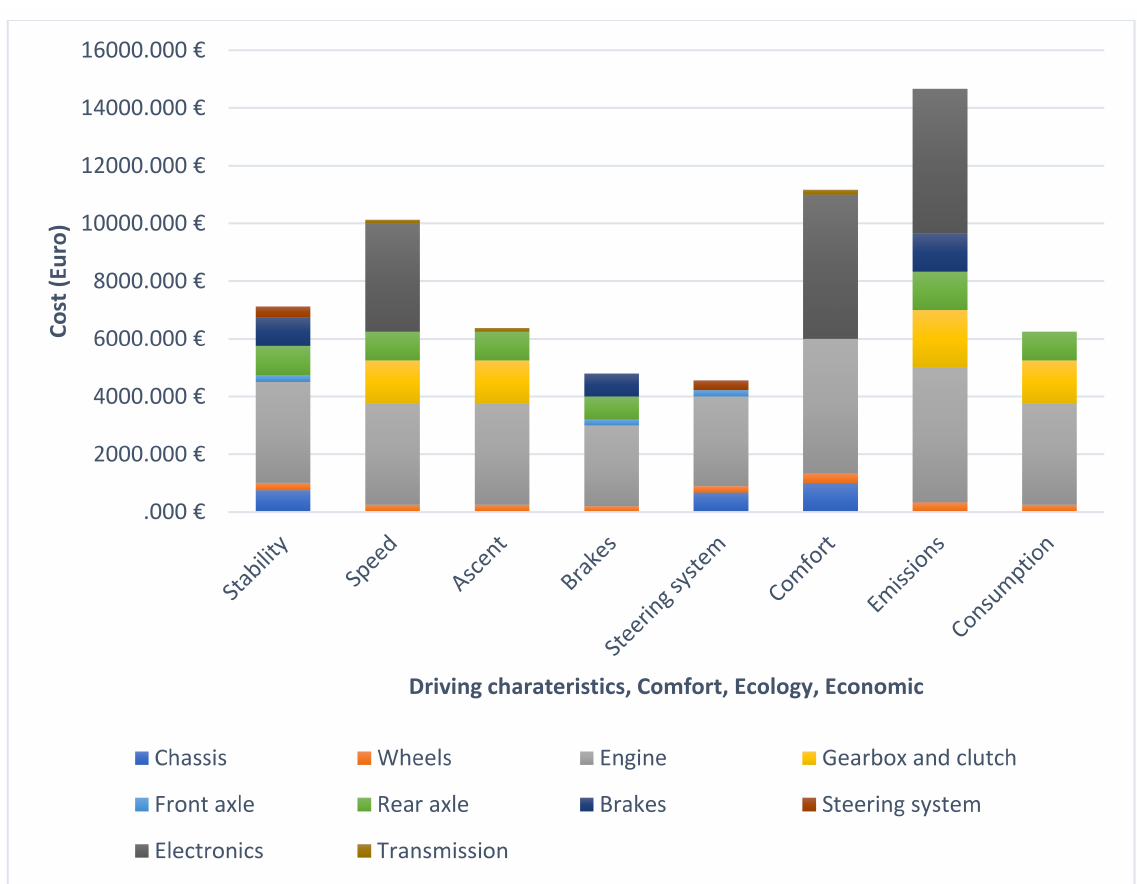
Figure 2. Cost structure of the main components relating to the functions of the